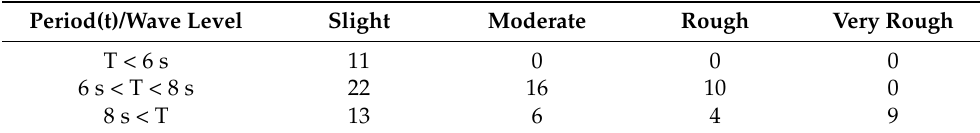
Table 2. The joint distribution of significant wave height and mean wave